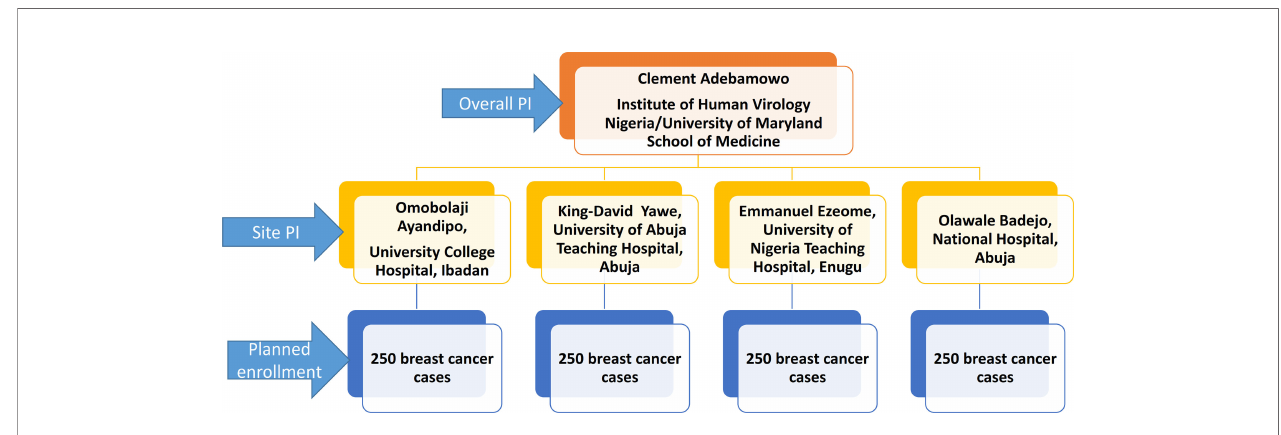
FIGURE 1 | Organogram and Coordination of the